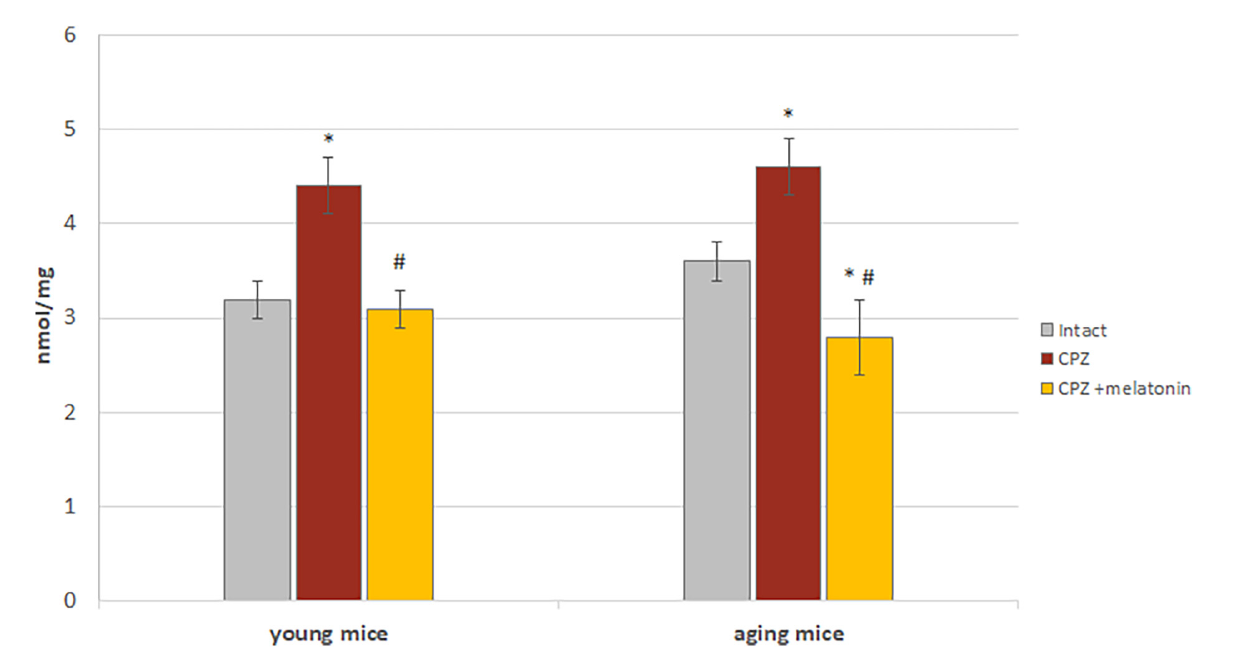
FIGURE8 The effects of cuprizone (CPZ) and CPZ + melatonin on malondialdehyde content in the brain of young and aging mice of experimental groups ( n = 5 in each group). Represented data are in 3 weeks of CPZ diet. Data are M ± SEM. ∗ p < 0.05 compared to intact group; # p < 0.05 compared to CPZ ( t